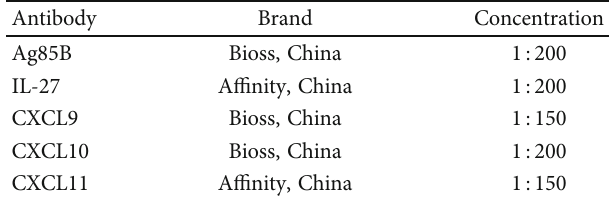
Table 1: Immunohistochemical antibody.